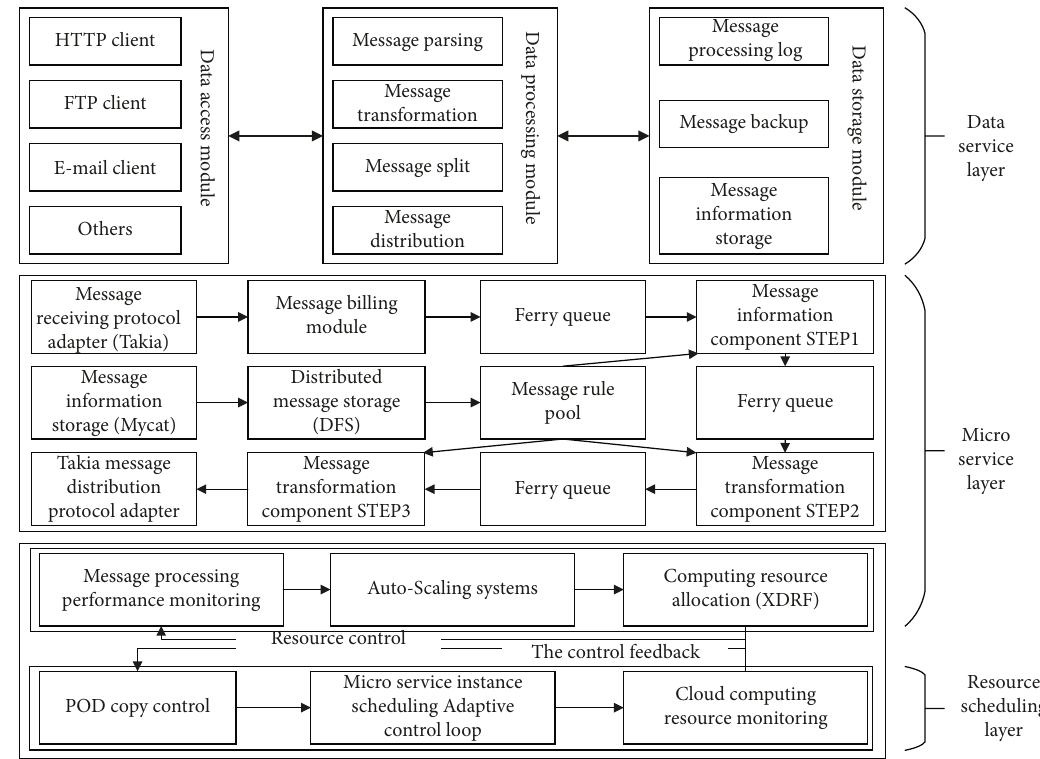
Figure 1: Hierarchical architecture of